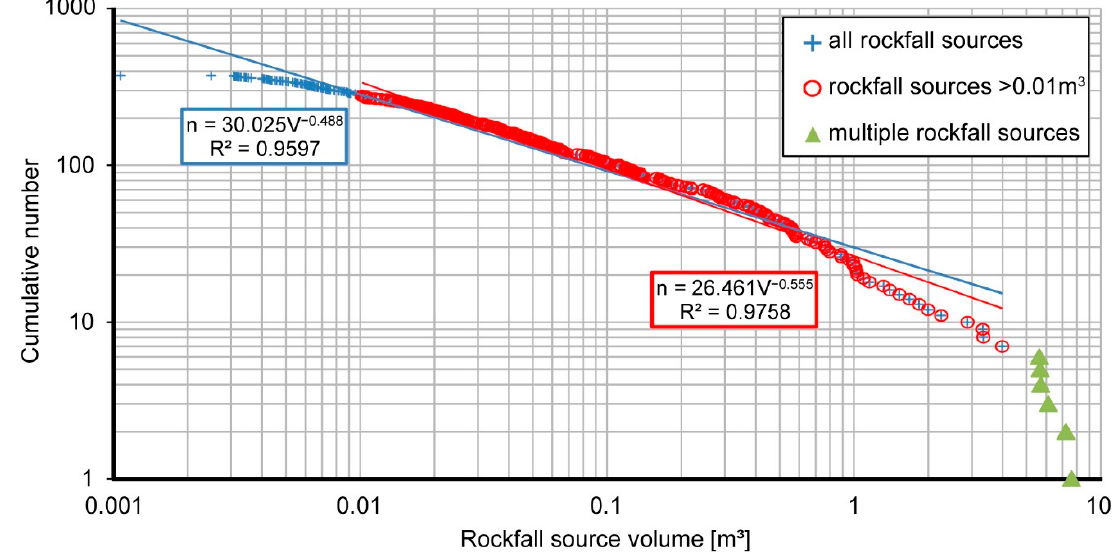
Figure 8. Magnitude–frequency plot of the rockfall sources from the full survey period (2010–2015) using the optimal α value according to method described in Section 3.3 for each rockfall source. One power law is fitted on overall rockfall sources and a second on the rockfall sources with volume >0.01 m 3 . The green triangles were clearly identified as multiple rockfall sources and are not considered for the regression fit.